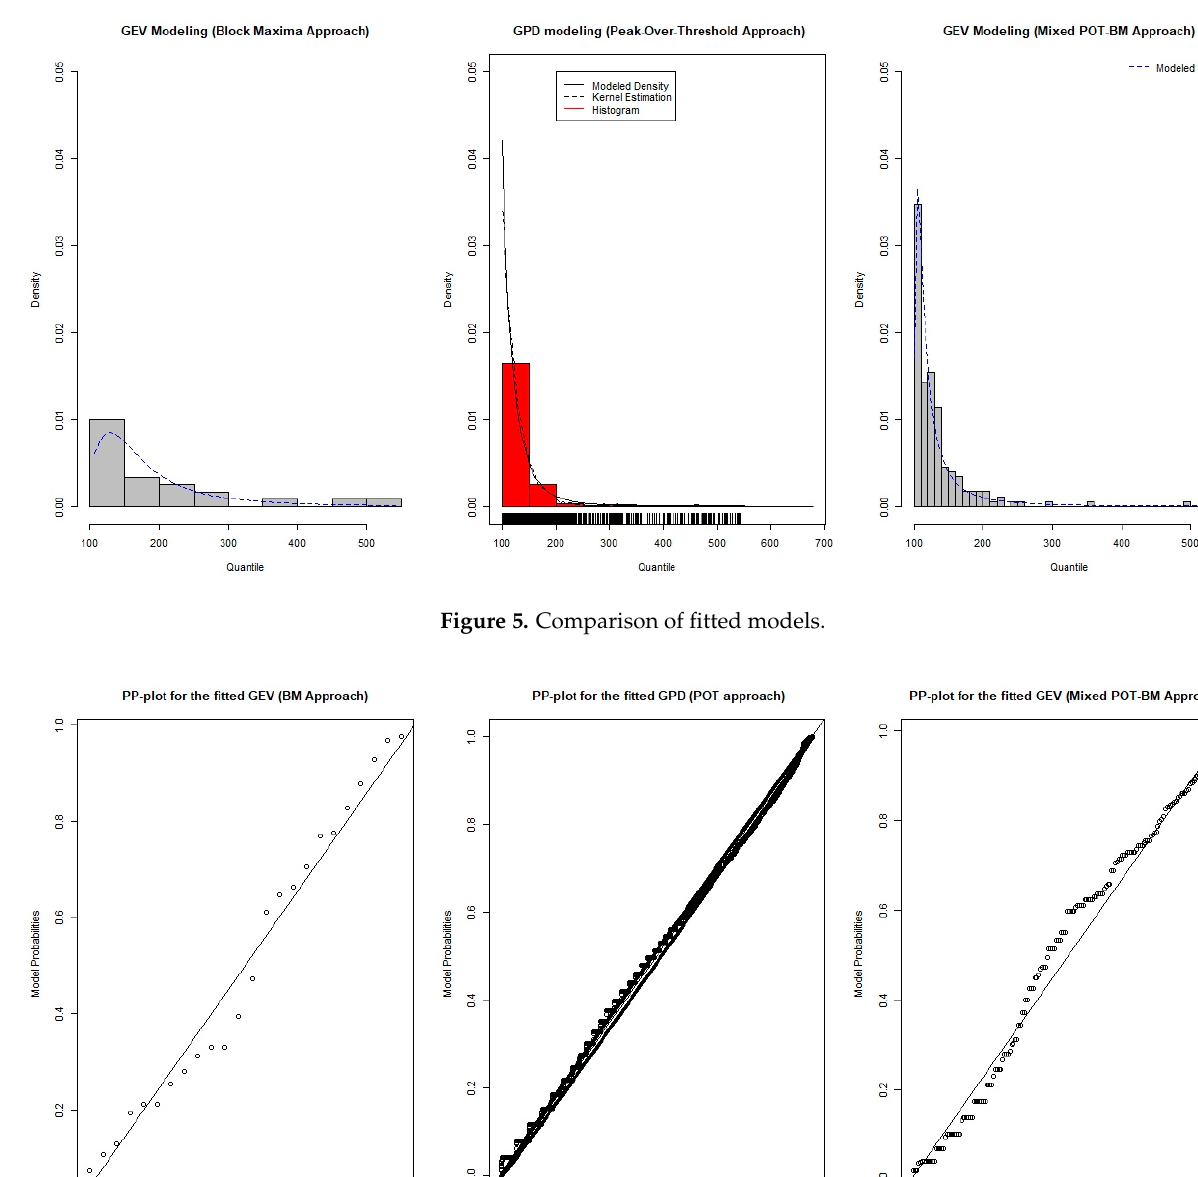
Figure 7. Autocorrelation function of data based on different extreme-value approaches. The highlighted result was obtained from the results presented in Table 3 and Fig- ures 5–7, which indicate that extreme-value modeling based on the BM approach is un- biased but less precise, with large estimation variance. However, though the POT ap- proach tends to demonstrate high precision in extreme-value modeling, it suffers from bias due to the violation of the independence assumption. Meanwhile, the mixed POT-BM approach can provide an improved tradeoff between bias and variance. In ad- dition, the mixed POT-BM approach can satisfy the unbiased properties of extreme-value modeling with much lower variance compared to the BM approach. In a similar vein, Figure 8 presents a comparison of the return level plot of each fitted extreme-value model. Based on Figure 8, the return level estimate determined by the GPD model based